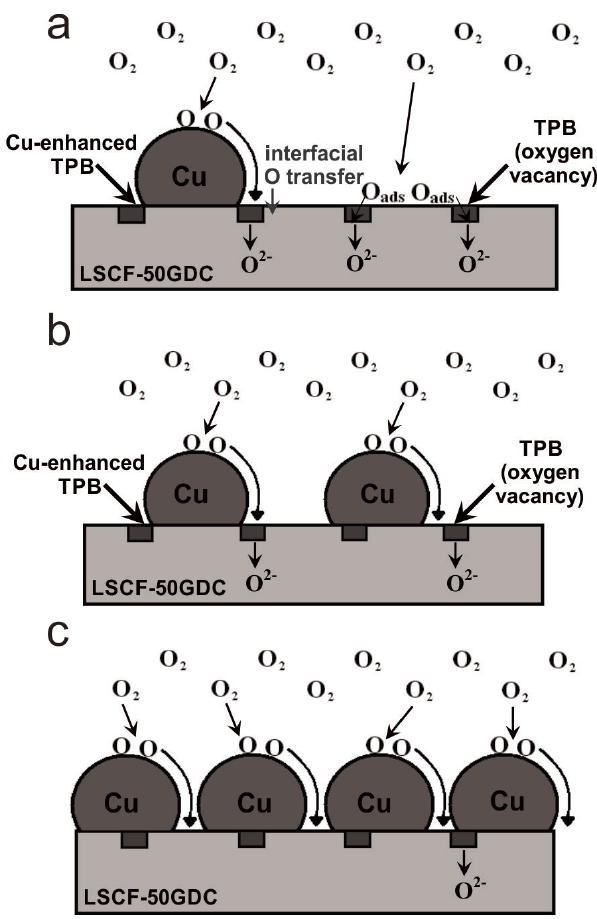
Figure 9. Schematic diagram of the Cu content on the electrochemical reaction of oxygen over the cathode TPB. The diagrams of a, b and c simulate LSCF-GDC doped with Cu, 1 wt.%, 2wt.% and 5wt.%, respectively. (Reprinted with permission from [39], 2010, WILEY- VCH Verlag GmbH & Co. KGaA,